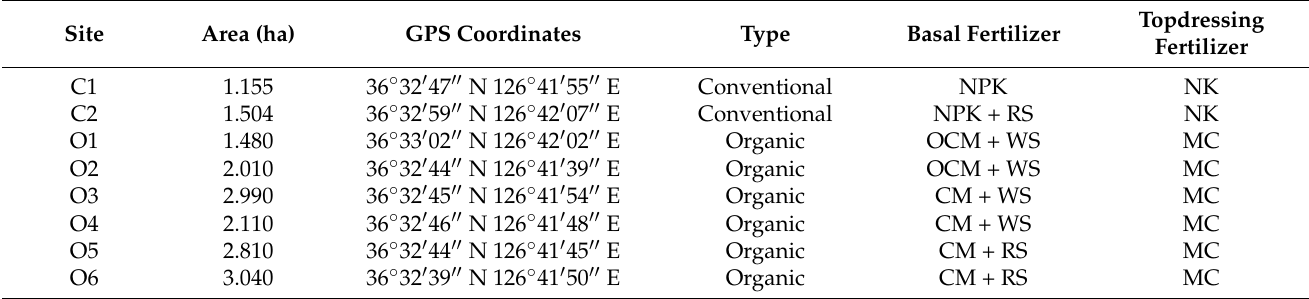
Table 1. Description of eight paddy fields used in this study according to the land management